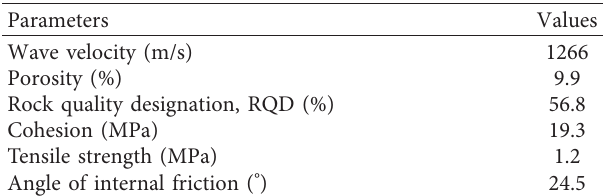
Figure 1: Diagrammatic drawing of isolated and peninsular coal pillar. Table 1: Physical and mechanical parameters of coal seam No. 22 in Bulianta coal